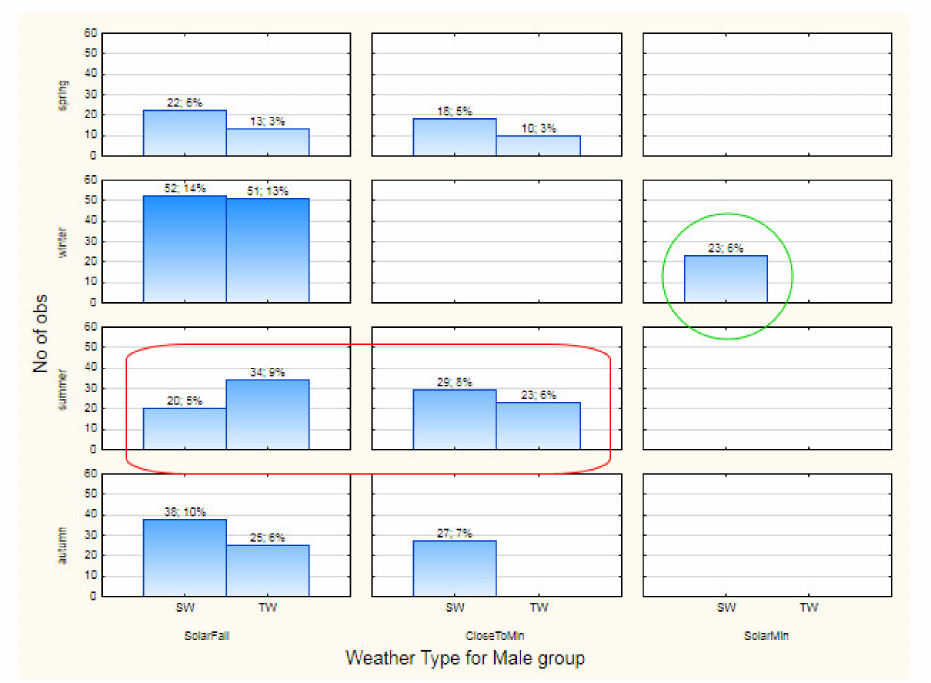
Figure 7. The distribution of the ratio between Space Weather (SW) and Terrestrial Weather (TW) characteristics, which differ when they are corresponding to the different medical events, by the phases of a solar activity cycle and calendar seasons. Male group from the medical call logs for the ischemia cases. The color contours are explained below in the main text of the